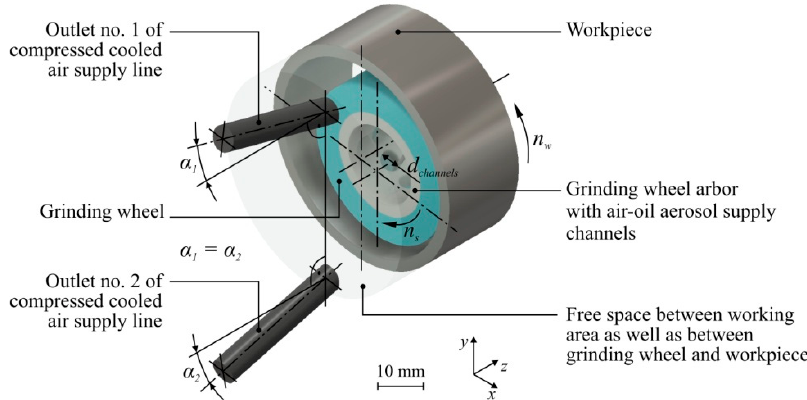
Figure 2. Geometrical model for simulation tests with main kinematic and geometric parameters: α 1 and α 2 —alignment angle of compressed cooled air supply line outlet no. 1 and 2; d channels —grinding arbor channels diameter; n s —grinding wheel rotational speed; n w —workpiece rotational speed.